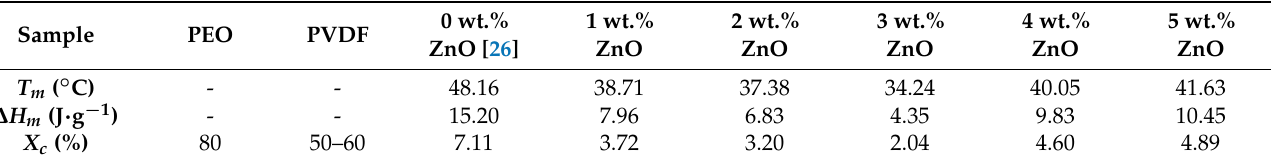
Table 1. Three parameters ( T m , ∆ H m , and X c ) of the SPEs and two pure substances (PEO and